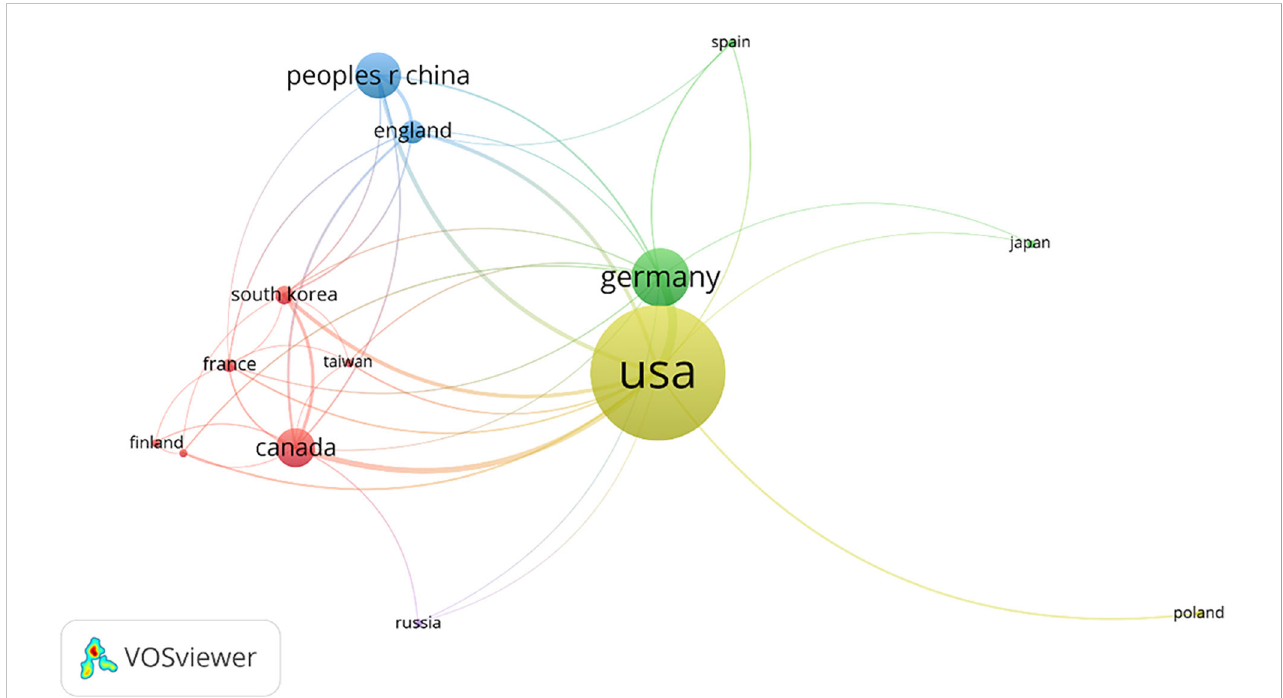
FIGURE 9 Co-authoring relationship Network map of countries ’ co-authoring relationships. In total, 14 countries showed a co-authoring